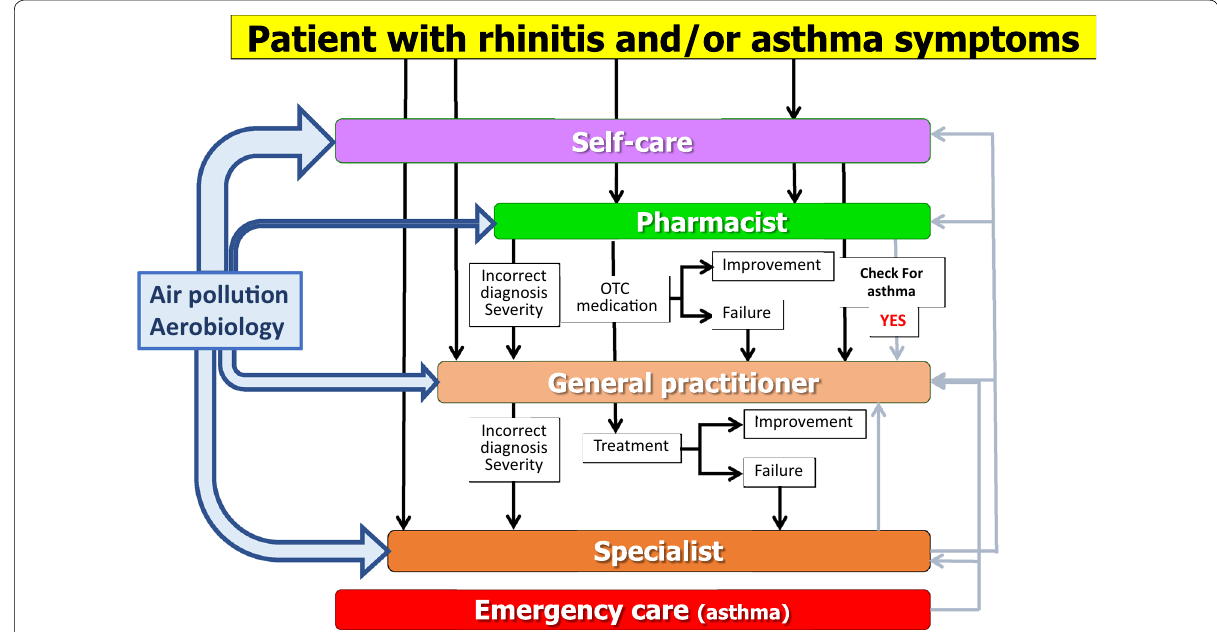
Fig. 3 Integrated care pathways for rhinitis and asthma multimorbidity embedding